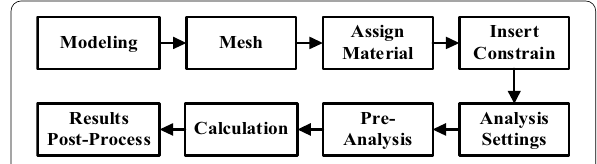
Figure 2 Simulation analysis flow chart in